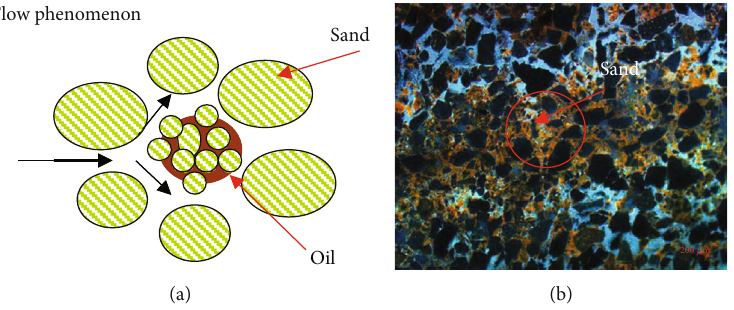
Figure 18: Reasons for residual oil formation caused by changes in pore structure. (a) Schematic. (b) Fluorescent picture.